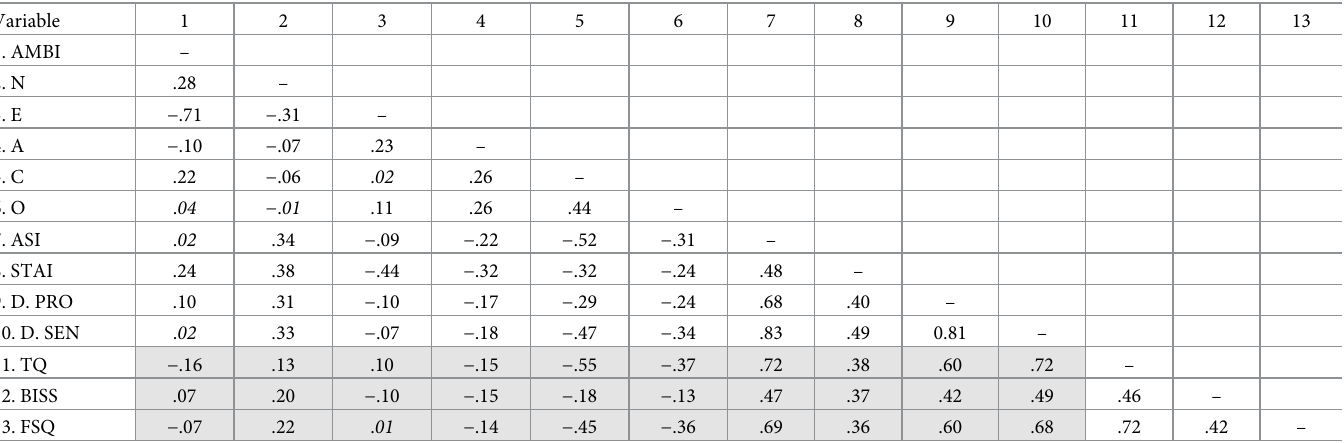
Table 3. Partial correlations among the study variables ( N = 1,134).